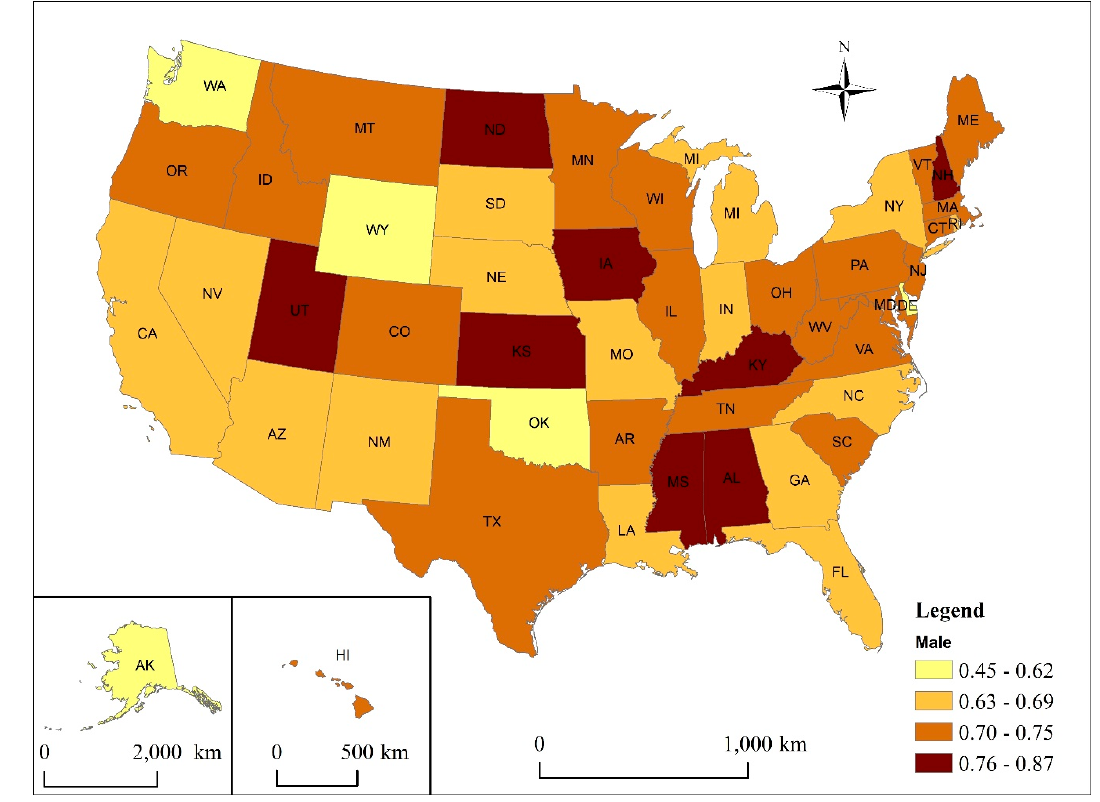
Figure 4. The proportion of male GISPs in each state.